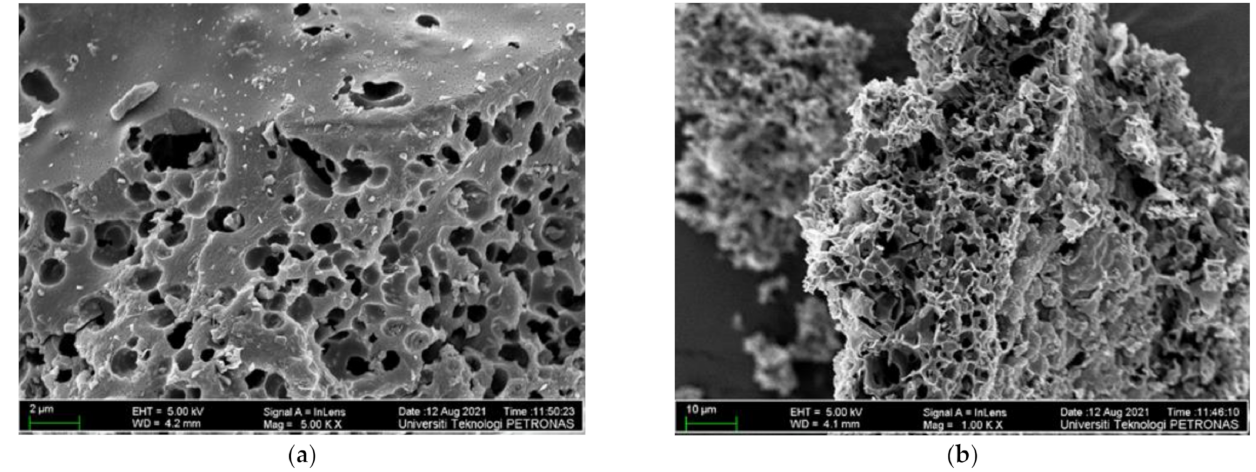
Figure 3. FESEM images at @ ( a ) 2 µ m and ( b ) 10 µ m for